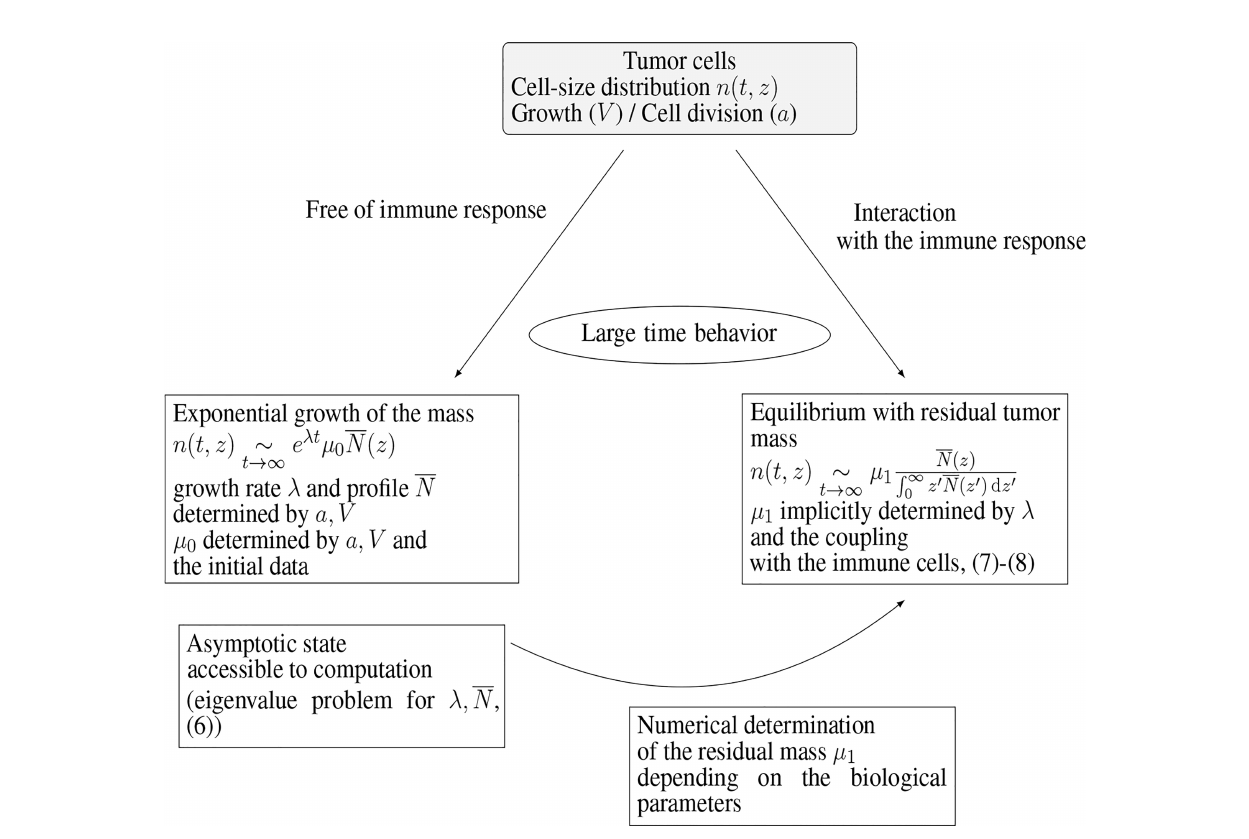
FIGURE 3 | Connection of the equilibrium state with the eigenstate of the growth-division equation, and interpretation of the residual tumor